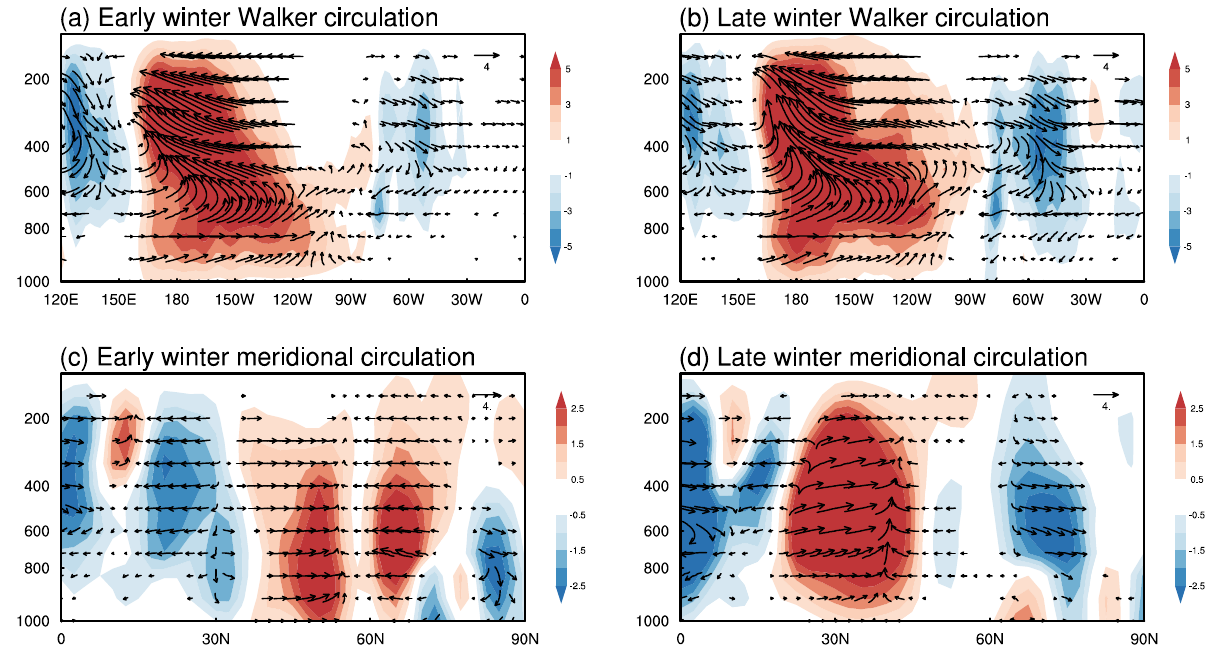
Figure 5. Zonal wind and vertical velocity (omega) anomalies (vector; m/s for zonal wind and Pa/s for omega) averaged meridionally over 5 ◦ S–5 ◦ N in ( a ) early and ( b ) late winter regressed upon the simultaneous Niño3.4 index. Meridional wind and vertical velocity anomalies (vector; m/s for meridional wind and Pa/s for omega) averaged zonally over 0 ◦ –50 ◦ W in ( c ) early and ( d ) late winter regressed upon the simultaneous Niño3.4 index. Omega anomalies are multiplied by a factor of − 400 in ( a , b ) and − 800 in ( c , d ) for display and are also shown in shading. During the following late winter, the anomalous tropical Walker circulation exhibits a similar pattern as that of early winter with an increase in amplitude, in particular over the tropical Atlantic (Figure 5b). However, there appears a very different structure of anoma- lous meridional circulation over the North Atlantic (Figure 5d). A prominent ascending during late winter can be observed near the region of 20 ◦ –40 ◦ N, which is of the opposite sign with respect to that during early winter. Accordingly, most regions of the subpolar North Atlantic experience the anomalous subsidence. The atmospheric response over the North Atlantic resembles the negative NAO-like pattern during El Niño in late winter.